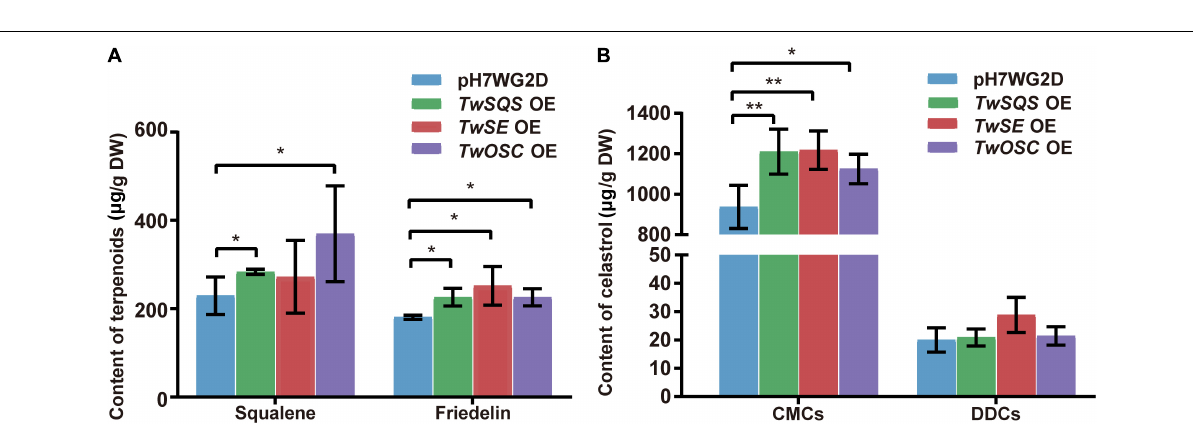
Frontiers in Plant Science |